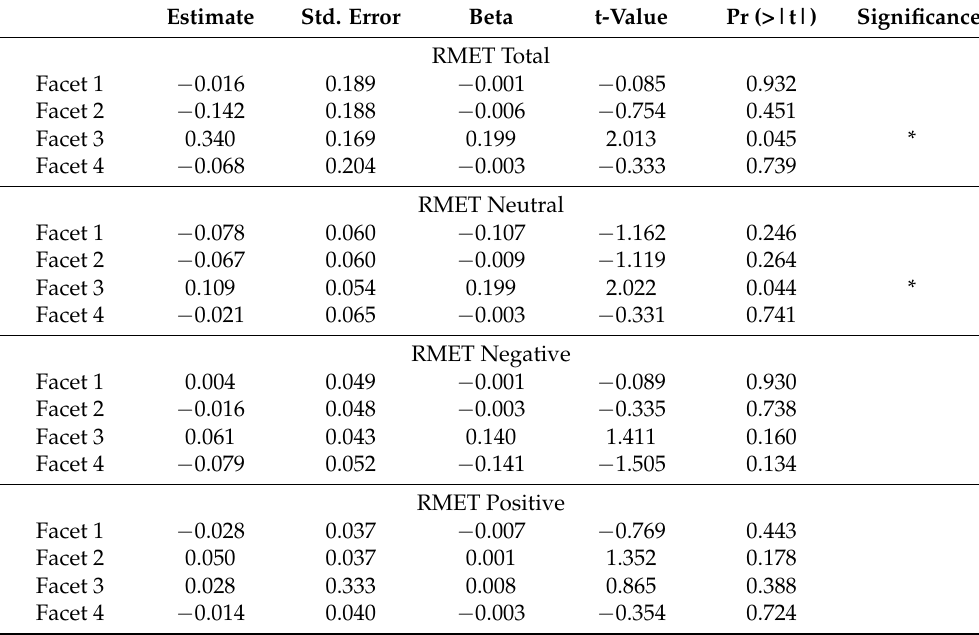
Table 3. This table shows the PCL-R/RMET multiple regression analysis. Estimate Std.